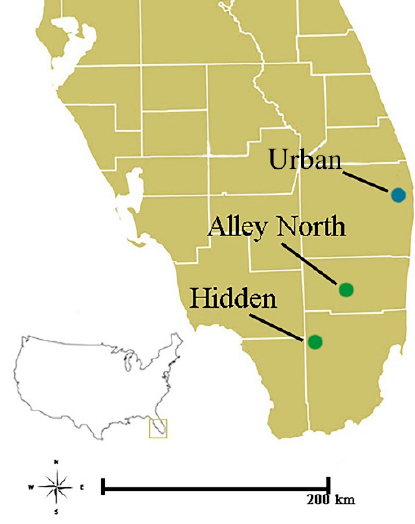
Figure 1. White Ibis ( Eudocimus albus ) rookery locations from which nestlings were sampled. The urban rookery (blue), located in Palm Beach County, FL, was sampled both in 2020 and 2021; the two natural rookeries (green), located in Broward and Miami-Dade Counties, were sampled only in 2021.